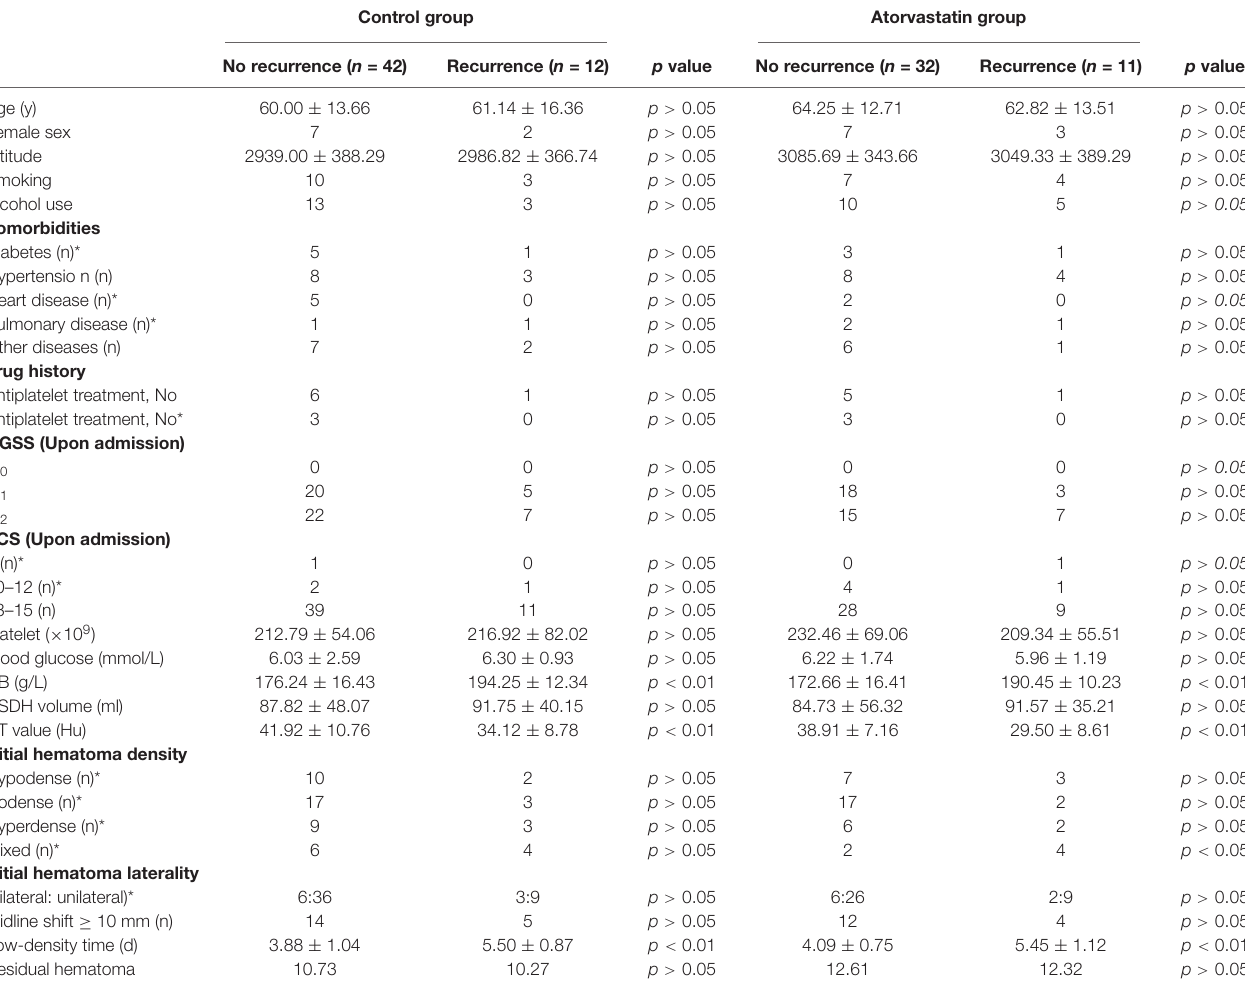
TABLE 2 | Characteristics of patients with CSDH included in the control and atorvastatin groups. Control